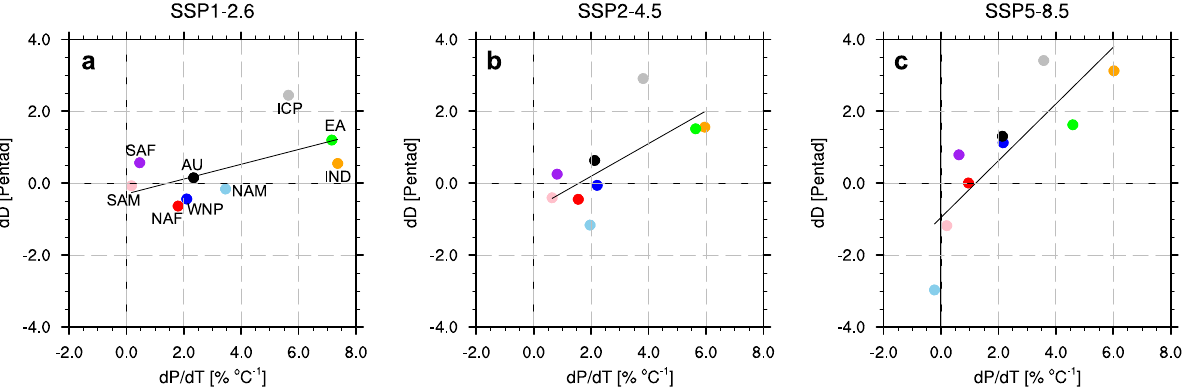
Fig. 4 Relationship between the changes in rainy season and changes in precipitation due to the increase in temperature. Individual dots indicate the regional monsoon domains in the long term (2081 – 2100) based on a SSP1 – 2.6, b SSP2 – 4.5, and c SSP5 – 8.5 scenarios. The lines depict the linear regression between the changes in duration and changes in precipitation according to the increasing